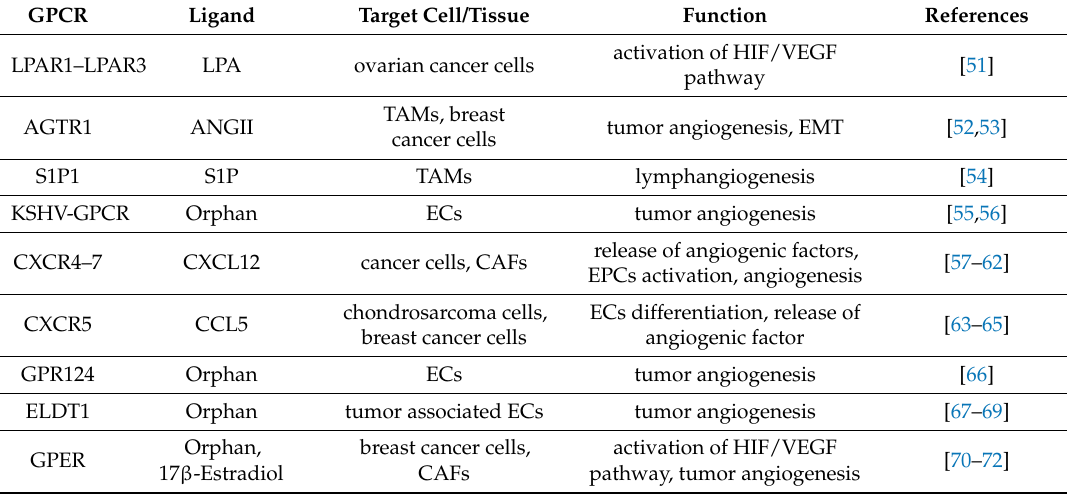
Table 3. GPCRs involved in the regulation of tumor